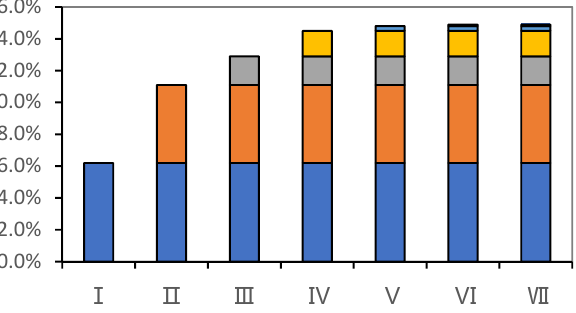
Figure 4. Overall classification accuracy after adding features according to PCA ranking.